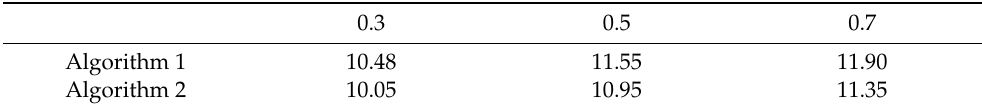
Table 3. The final entropy value of the image convergence after 10 iterations of each algorithm under each sampling